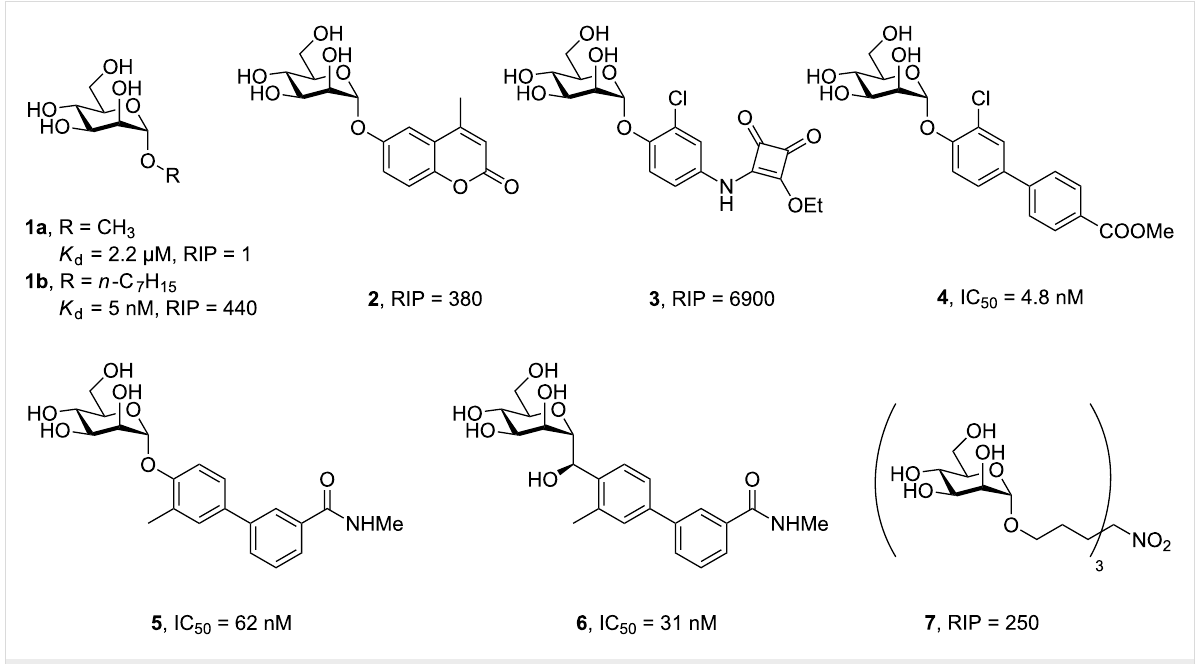
Figure 1: Mannosides as inhibitors of the lectin FimH from uropathogenic Escherichia coli .